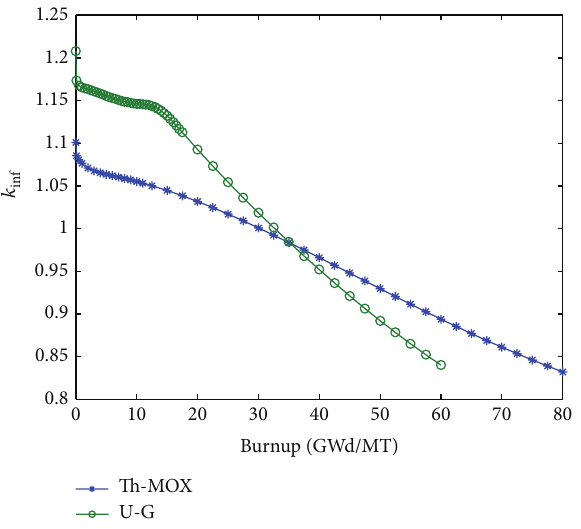
Figure6:Thepinpeakpowerasfunctionofburnupforthestandard and 1/3 Th-MOX